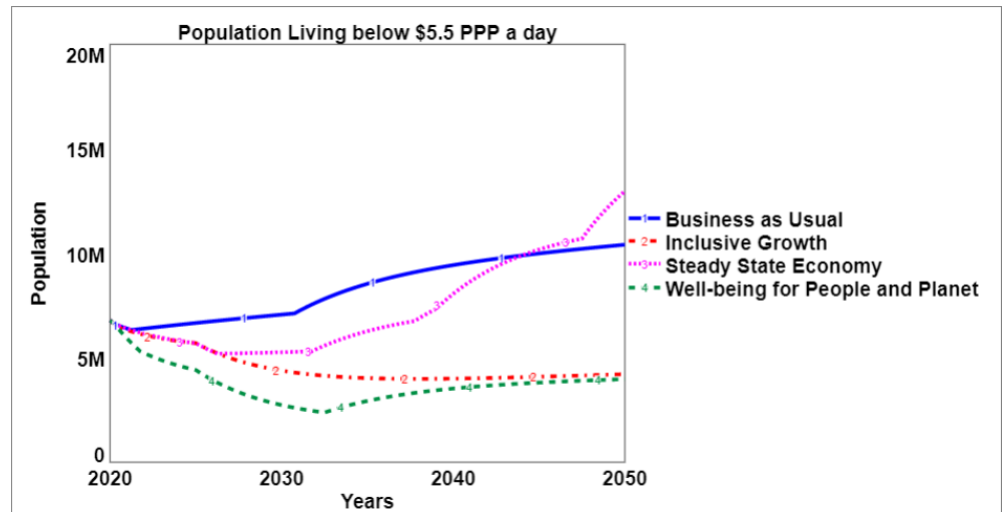
Figure 6. Population of people living below $5.50 a day.